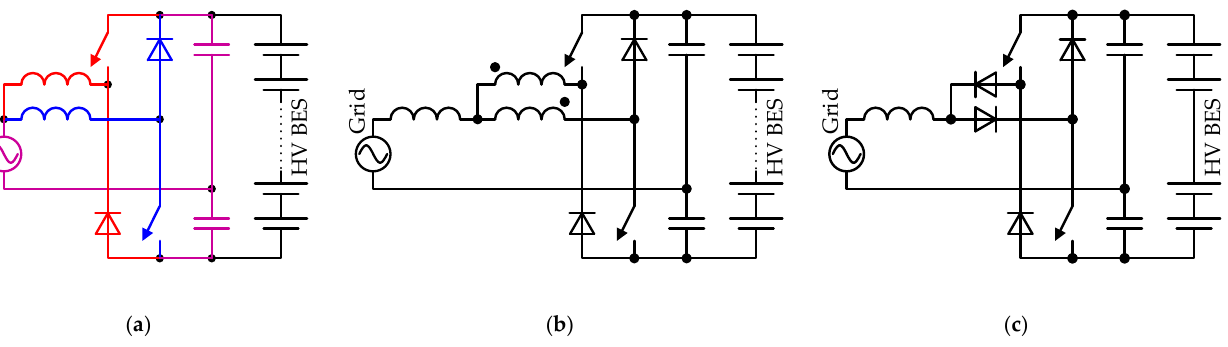
Figure 11. Dual-buck grid converter: ( a ) derived from half-bridge, ( b ) magnetically coupled branches, ( c ) diode coupled.